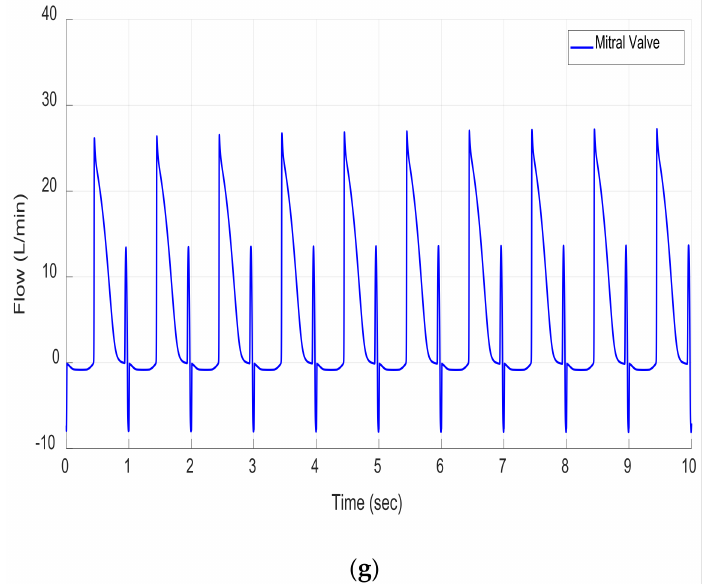
Figure 5. Hemodynamic variable results for the moderate healthy condition; ( a ) left ventricle pressure; ( b ) aortic pressure; ( c ) left atrium pressure; ( d ) left ventricle volume; ( e ) systemic flow; ( f ) aortic valve flow; ( g ) mitral valve flow.